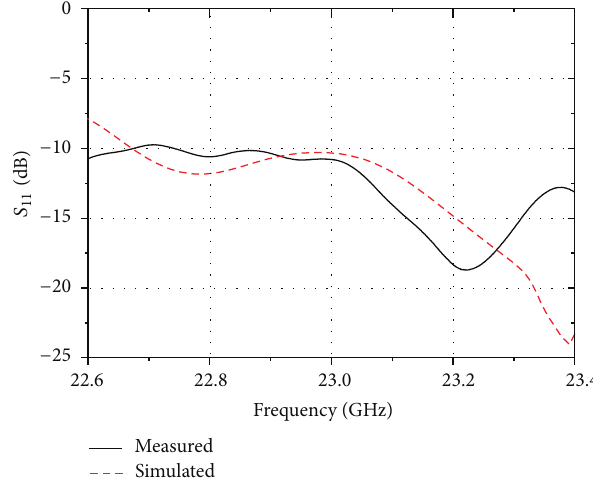
Figure 3: Reflection coefficients of the fabricated 16 × 22 SIW slot array antenna.